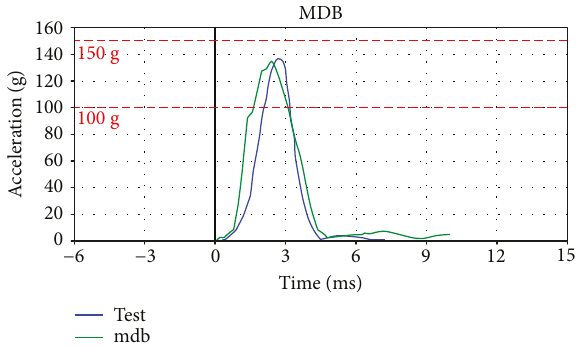
Figure 11: Acceleration-time curves of the dummy head under lateral collision.